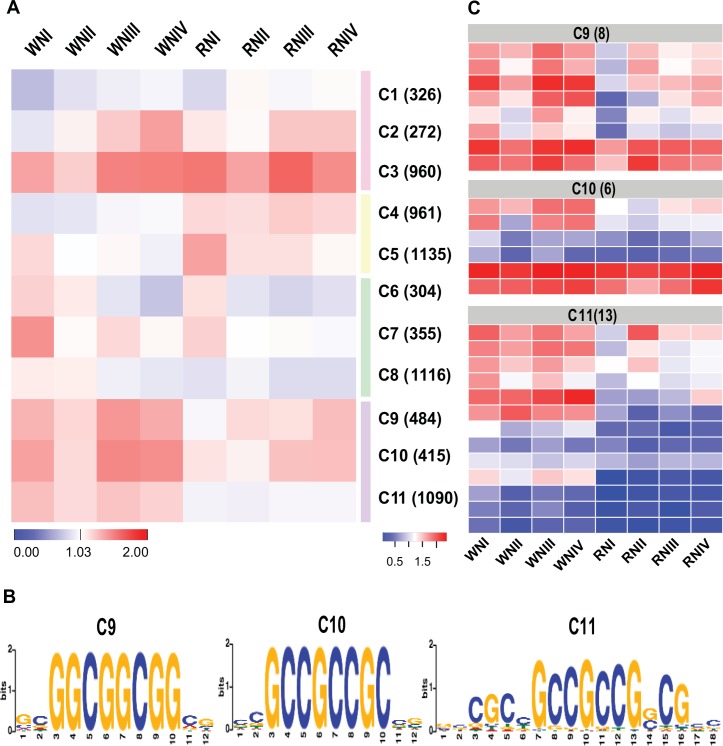
Construction of rtcs-dependent regulatory networks of root development.(A) Expression signatures across wild-type and rtcs libraries under normal-N condition were used to cluster genes with dynamic expression during root development. Eleven co-expression clusters fell into four distinct clades of expression, cluster 9, 10 and 11 were highly enriched in wild-type. Each cluster is assigned a number identifier and the number of genes associated with each cluster is indicated (right). The heatmap represents cluster centers (FPKM values were log10-transformed). (B) De novo cis-regulatory motifs overrepresented in the promoter regions of the genes in co-expression cluster 9, 10 and 11. Three cis-regulatory motifs were obtained with significant similarity to the reported binding sites of the AP2-EREBP superfamily. (C) Expression analysis of 27 AP2-EREBP genes in wild-type and rtcs. The number of AP2- EREBP family members is shown at the top.